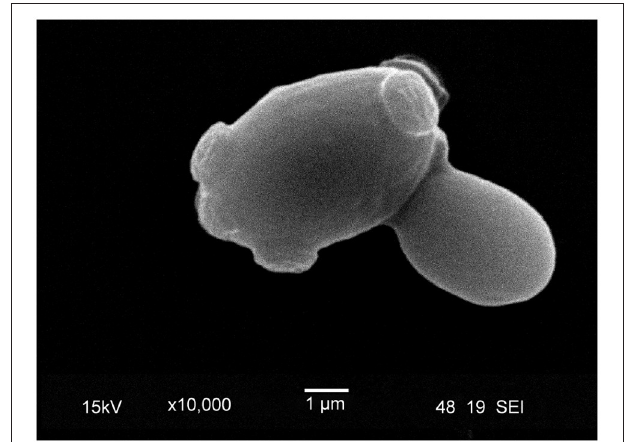
FIGURE 5 | Scanning electron microscope image of lager yeast (TUM 34/70) with bud scars. During the budding process, a daughter cell is created, and the surface, on which the bud formed, is covered by a chitin ring, a marker of replicative aging. The inner surface of the chitin ring consists of beta-glucan.